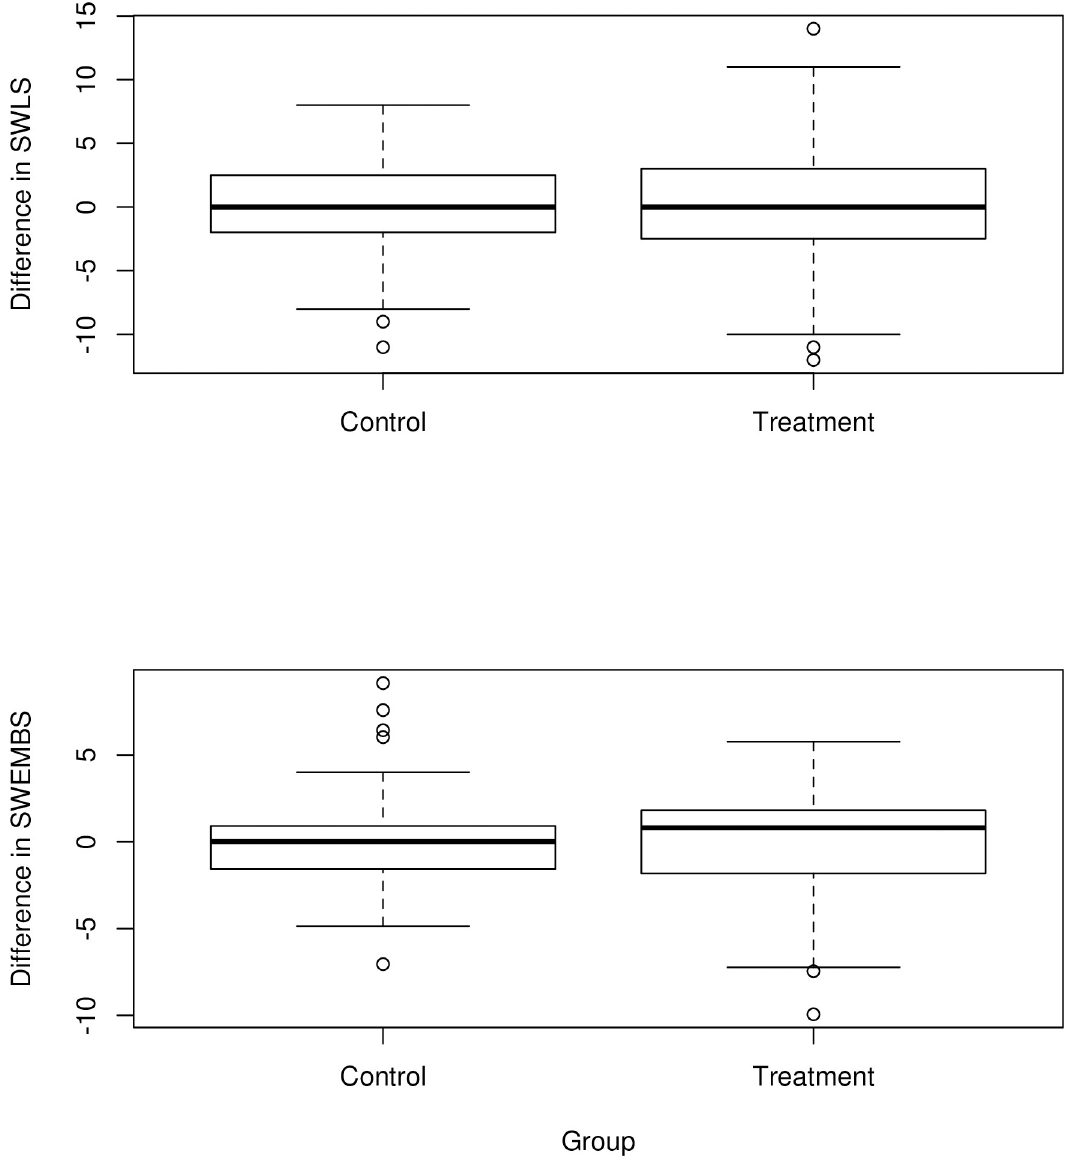
Fig 3. Differences in subjective well-being